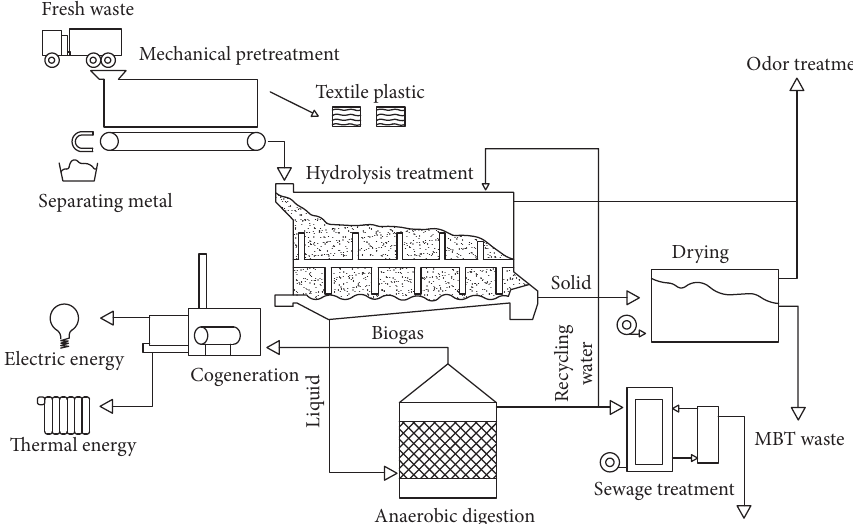
Figure 1: Schematic of mechanical biological treatment (MBT) of municipal solid waste